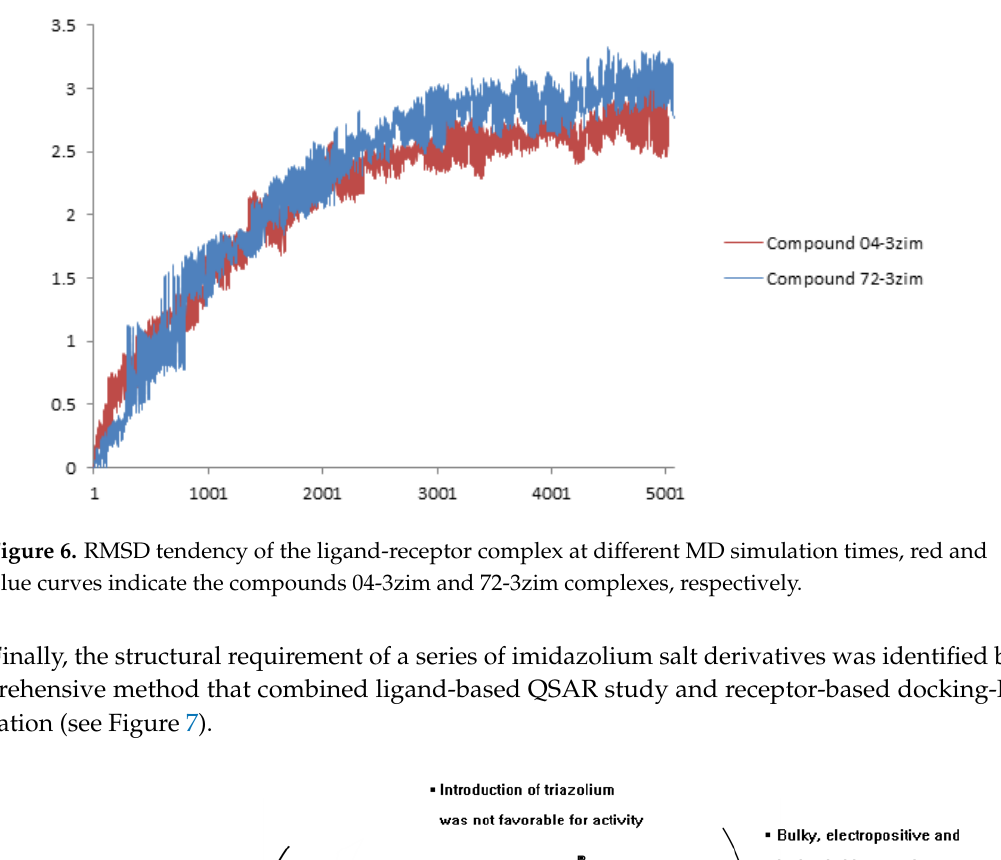
Figure 5. Molecular Dock interaction of CNX-1351 ( a ) and compounds 04 ( b ), 72 ( c ) and 74 ( d ) with the amino acids in the active pocket of protein 3zim.